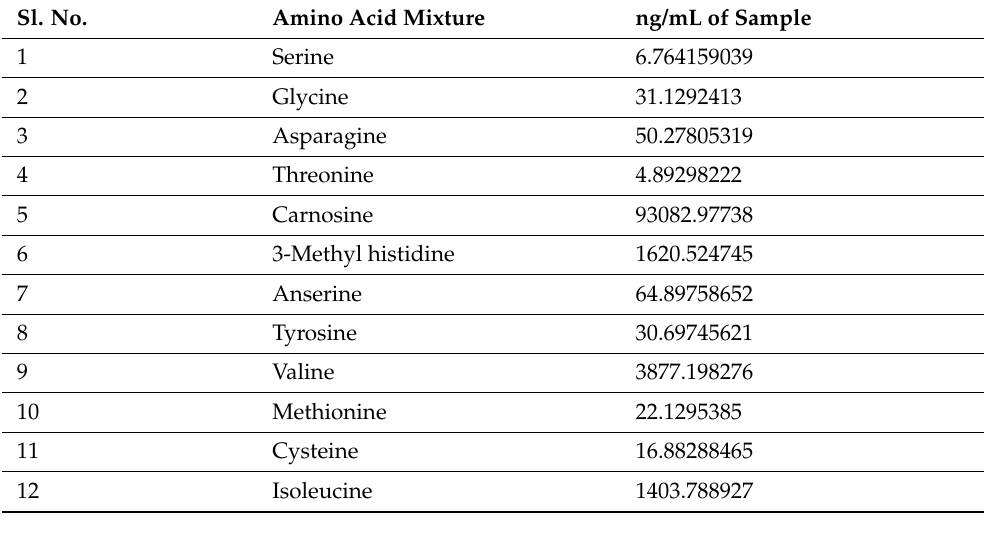
Table 3. TAA content in R. palustris NR MPPR (HPLC).